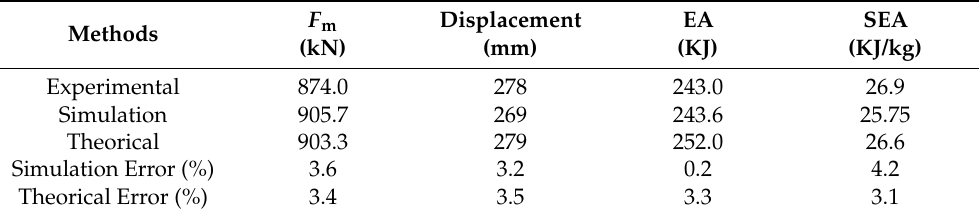
Table 2. Comparison of experimental results, FE simulation results, and theoretical results. F m Displacement EA SEA Methods (kN) (mm) Experimental 874.0 278 243.0 Simulation